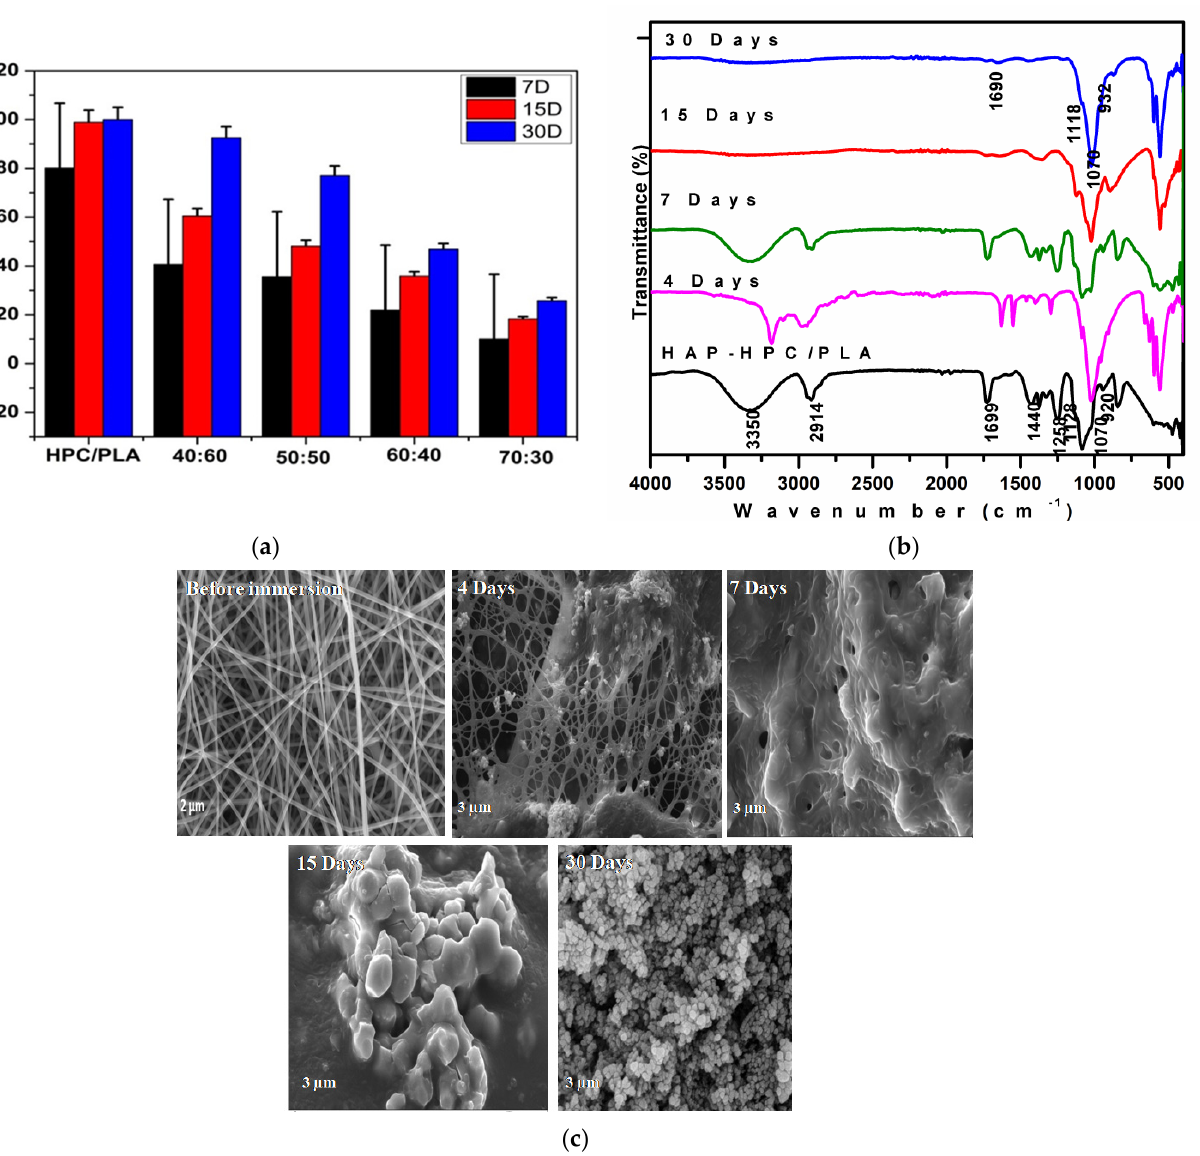
Figure 7. ( a ). Degradation rate of different composition ratios. ( b ). FTIR analysis of nanofibrous mat at different intervals of SBF immersion. ( c ). SEM analysis of nanofibrous mat at different intervals of SBF immersion